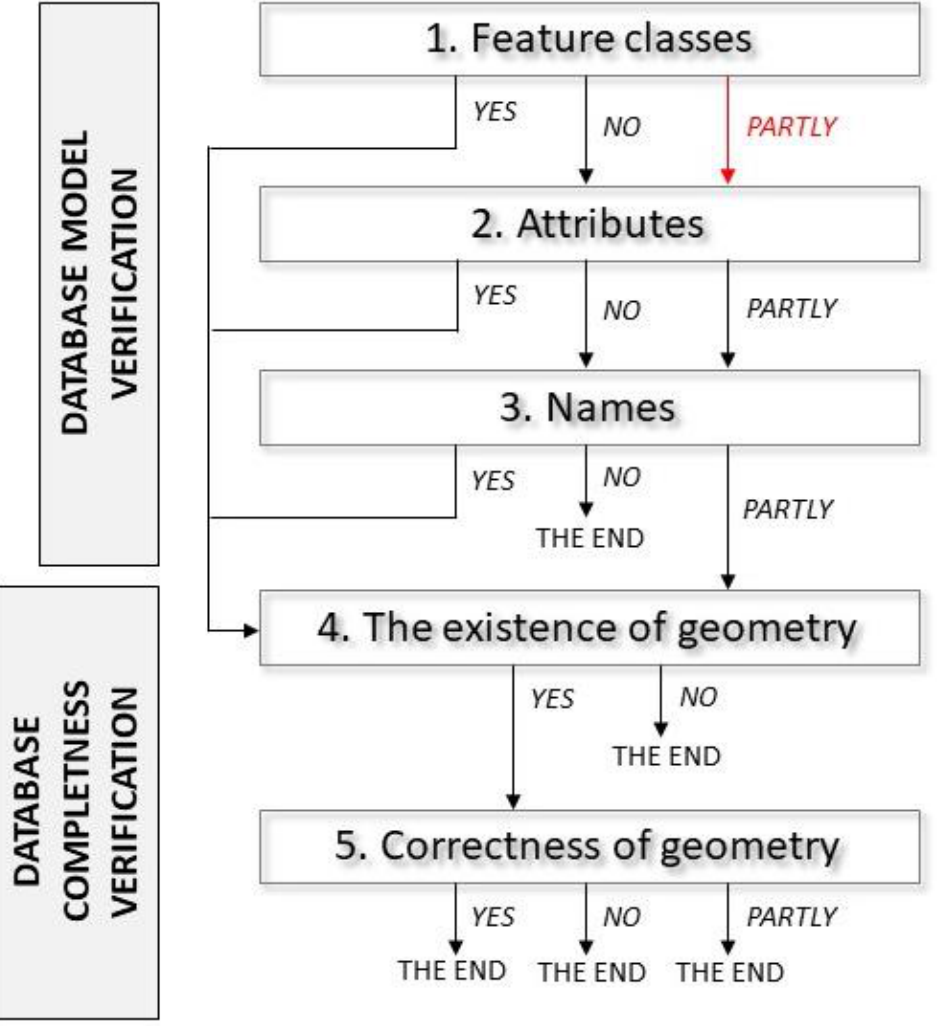
Figure 1. The assessment procedure (own work).